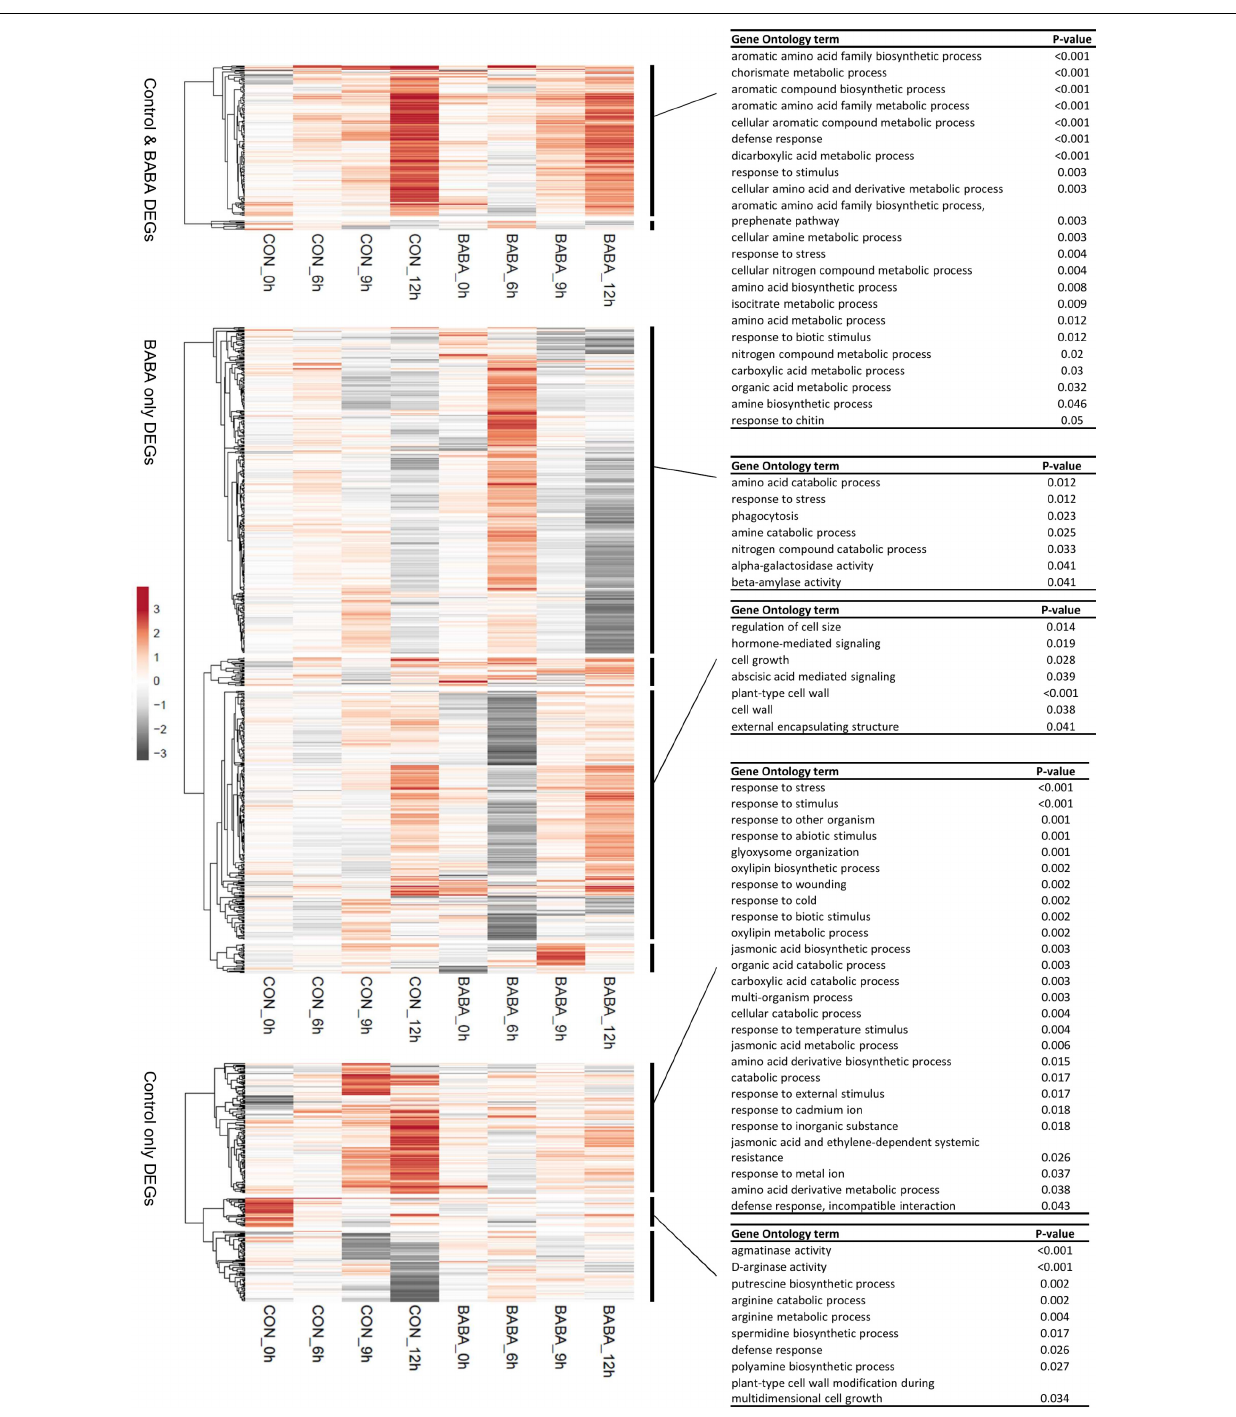
Frontiers in Plant Science |